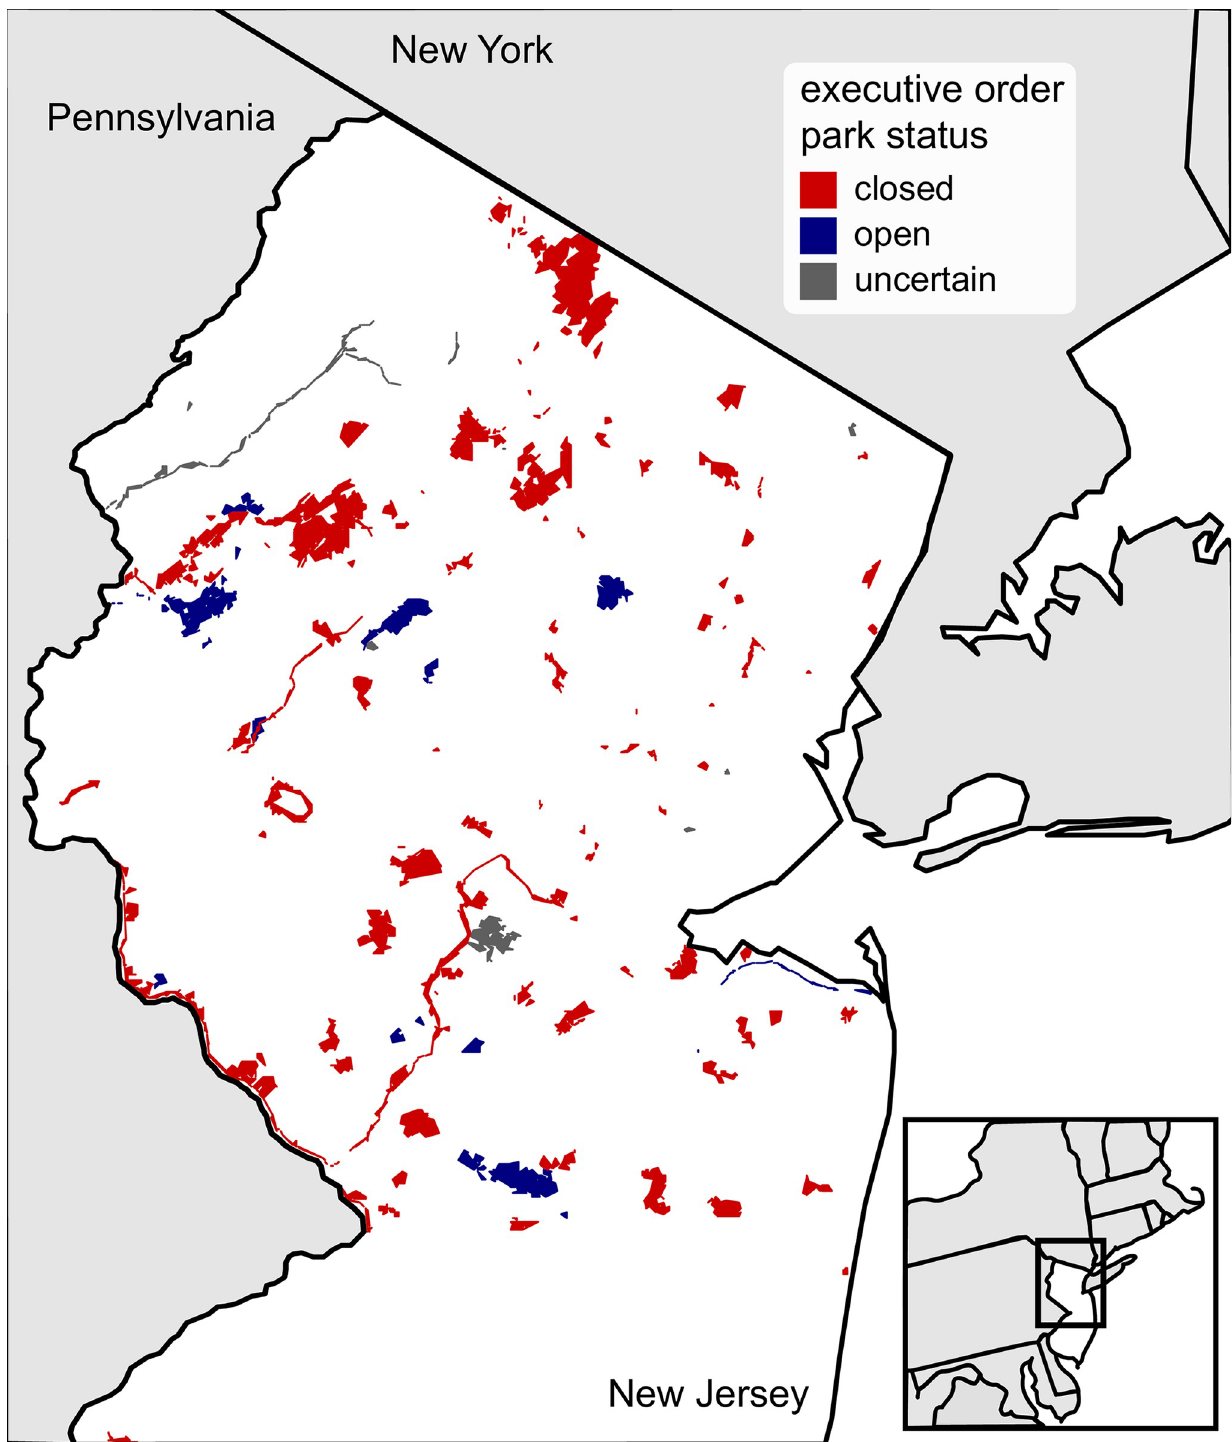
Fig 2. The distribution of New Jersey parks included in this study ( n = 98). Parks in blue ( n = 12) remained open through the whole study period, whereas parks in red ( n = 79) were closed during the governor’s executive order (April 8th—May 2nd). For parks colored in grey ( n = 7), we were unable to find information on their status during the park shutdown order, so these parks were excluded from all analyses comparing closed and open parks.